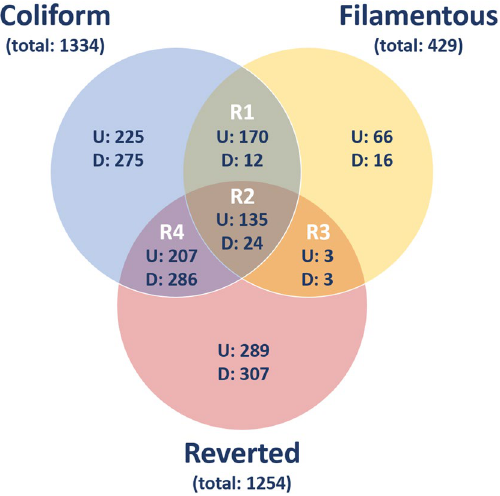
Figure 2. Venn diagram of differentially expresses gene entities in HBEP cells stimulated by different morphological states of ESBL019 compared to unstimulated controls. Shown in blue; HBEP cells stimulated by the Coliform, in yellow; HBEP cells stimulated by Filamentous bacteria and pink; HBEP cells stimulated by Reverted bacteria. Up and down regulated entities are designated U and D respectively (n = 4 in each group). Overlapping regions represent entities that are present in Coliform and Filamentous (R1 + R2), Filamentous and Reverted (R2 + R3) or Coliform and Reverted (R2 +